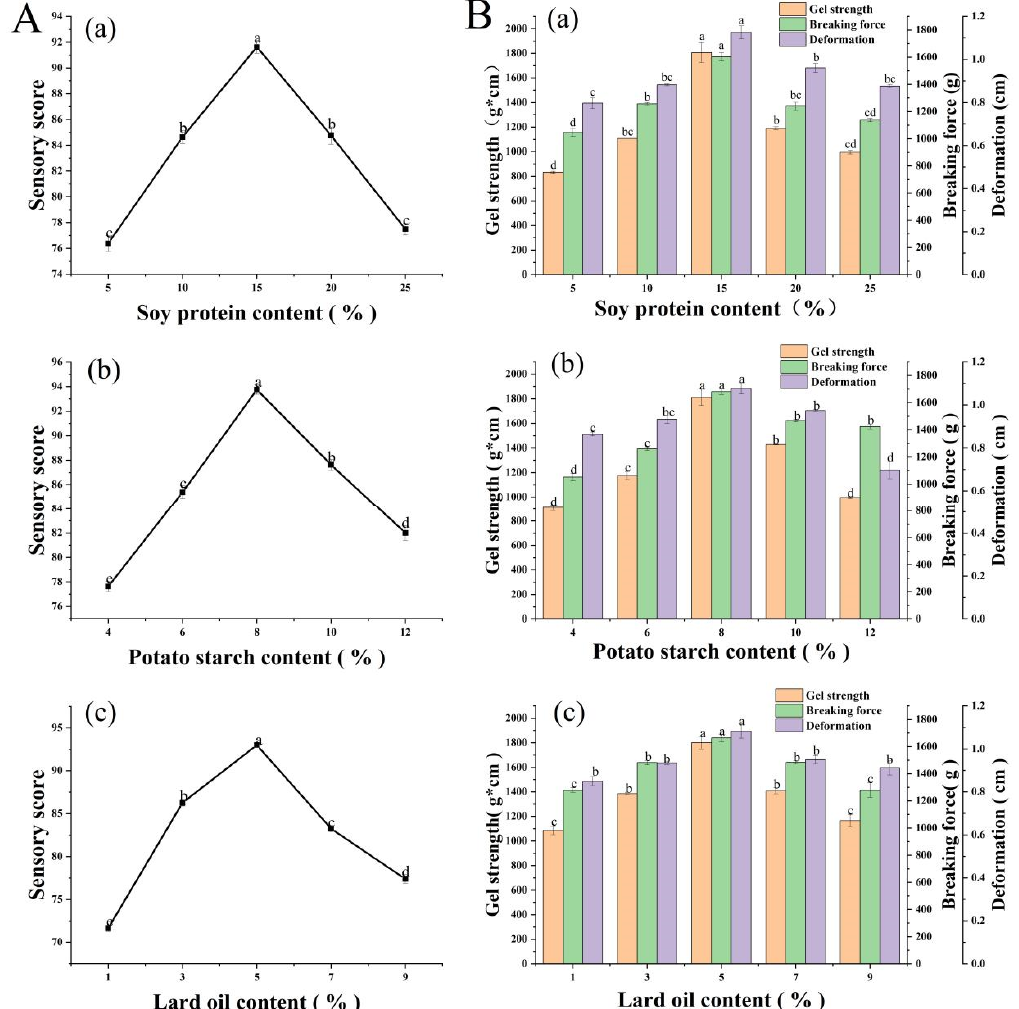
Figure 1. Changes in sensory score ( A ) and gel strength ( B ) of fish sausages with different textured soy protein (TSP) mixture content ( a ), potato starch content ( b ), and lard oil content ( c ). Significant differences between samples (p < 0.05) are denoted by lowercase letters.